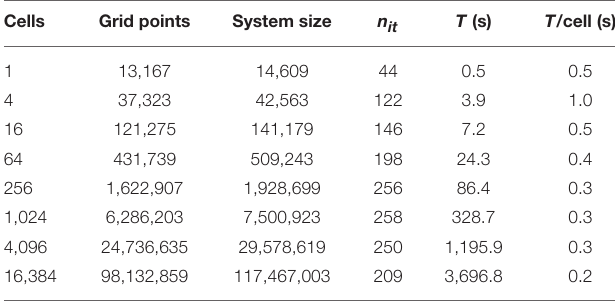
TABLE 7 | CPU times for the finite difference method for a passive membrane